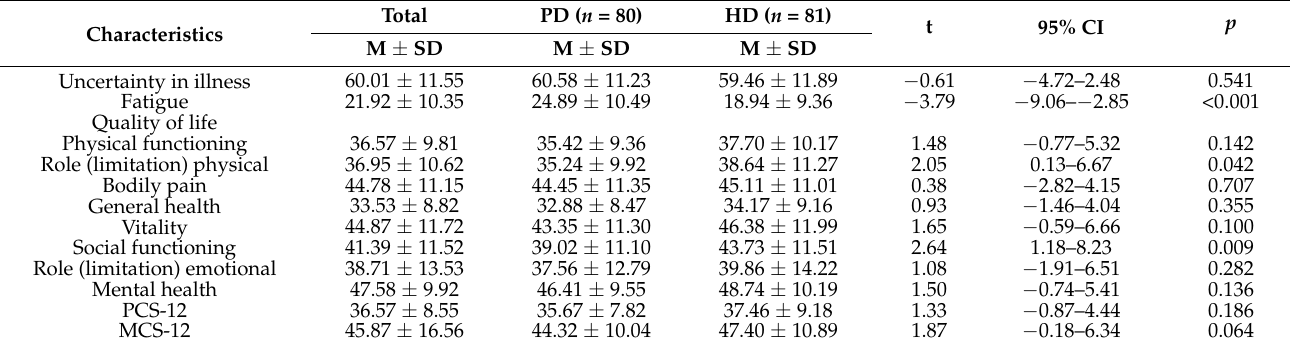
Table 2. Differences in uncertainty, fatigue, and health-related quality of life, according to the type of dialysis ( n = 161).